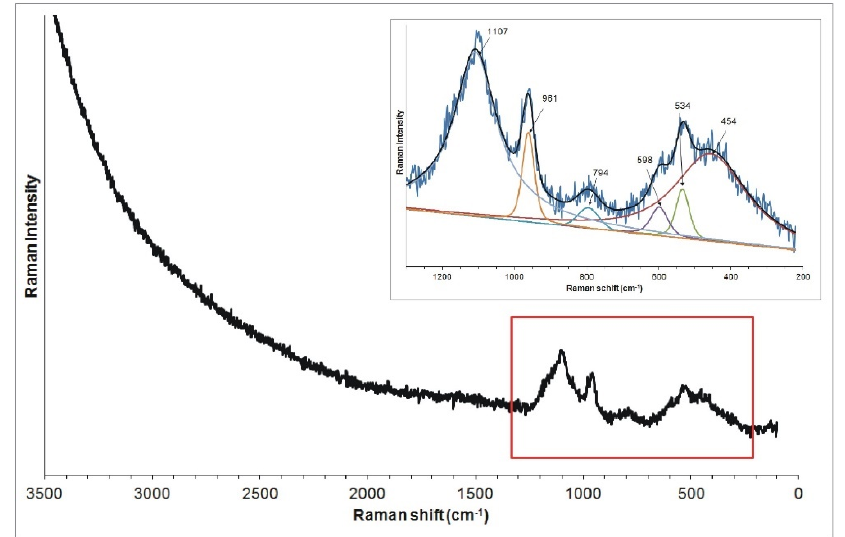
Figure 8. Representative characteristic Raman spectrum of the surface of the blue bead.